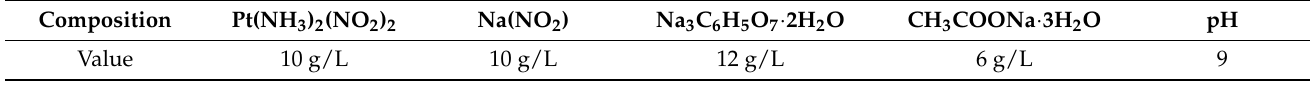
Table 2. Chemical composition of the alkaline Pt-plating solution.